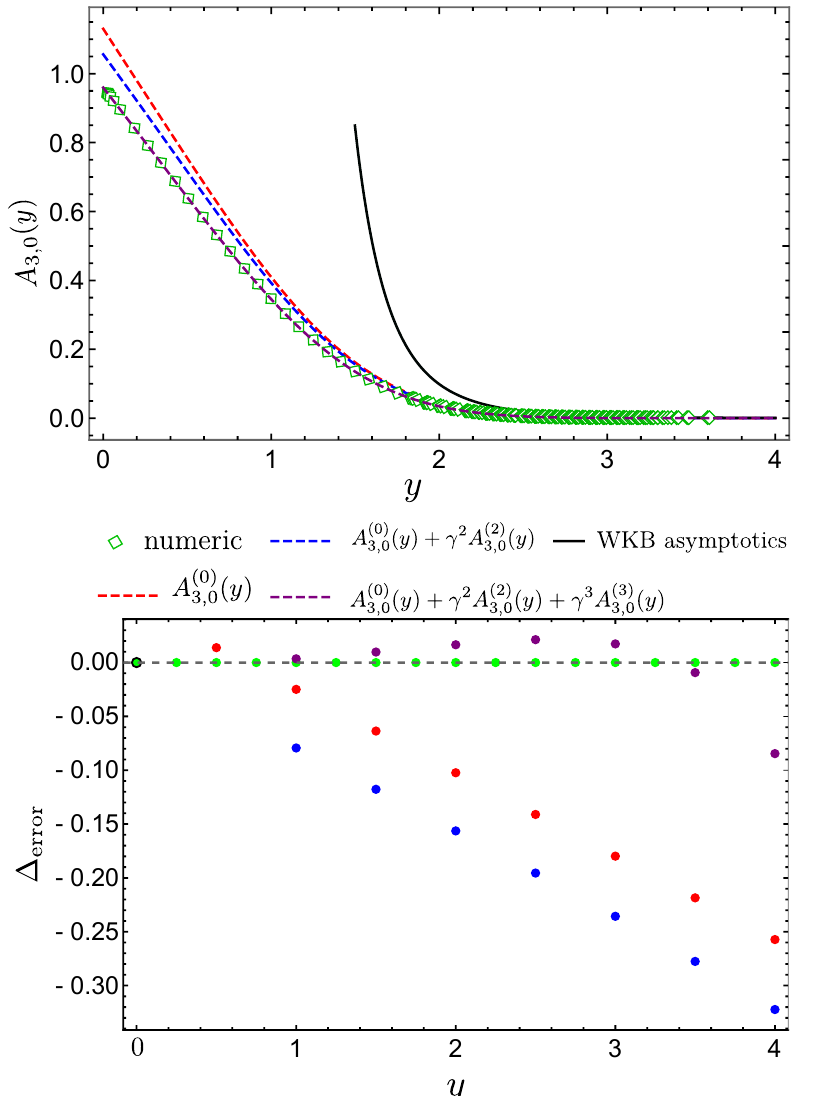
Figure 5 . Numerical and analytic evaluation in the local coordinate system around a cubic zero defined at the beginning of subsection B.5.2. Parameters used are chosen in a rather generic way: ~ = 1 , a = − 4 , b = 1 . (Top) Various approximate evaluations of A 5 21 2 better with higher corrections included. (Bottom) ∆ ∆ for the WKB asymptotic solution since the error is too big. The legend of coloring is shared error in both